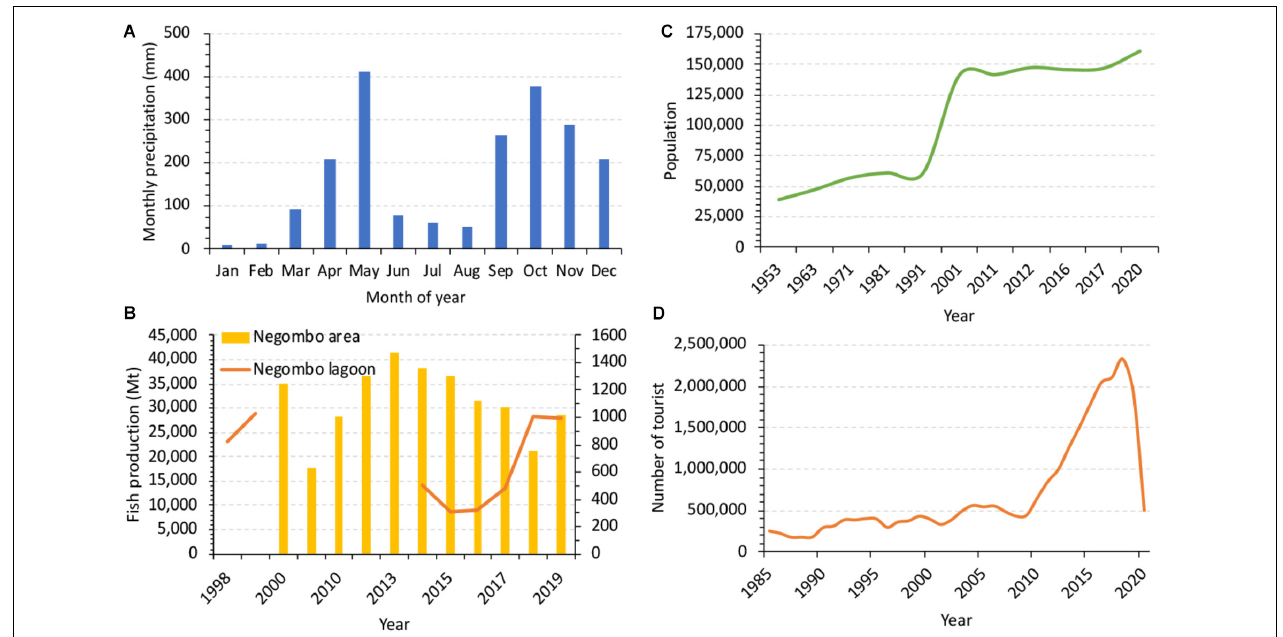
FIGURE 2 | Information of (A) monthly precipitation, (B) fish production, (C) population, and (D) tourists in the Negombo lagoon and the adjacent area.